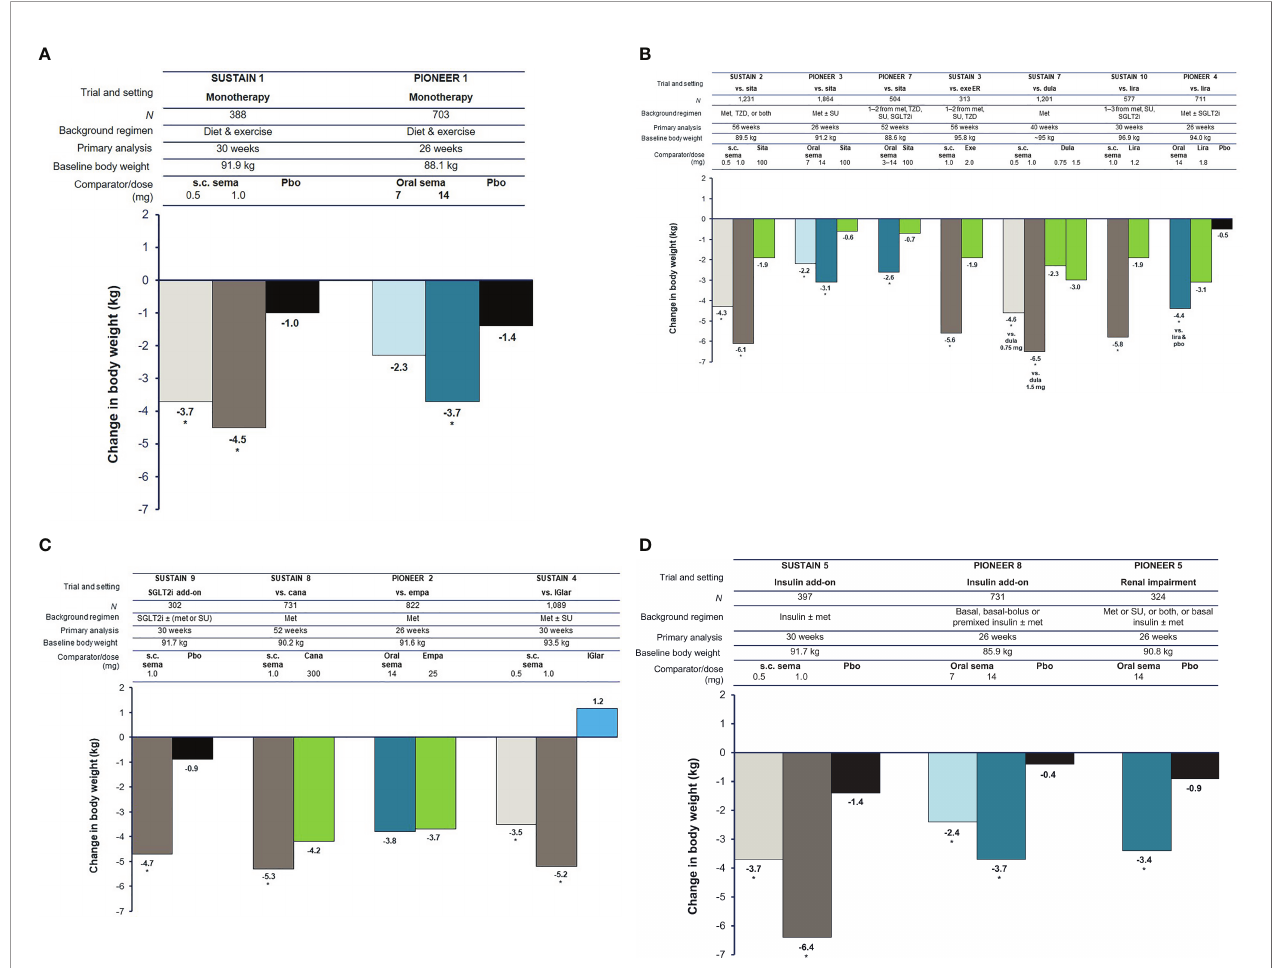
FIGURE 2 | Reductioninbodyweightwithsemaglutideandcomparators(16 – 20,22 – 26, 31,33). (A) TrialsinearlyT2D(3 – 4years). (B) TrialsinestablishedT2D(6 – 10 years) withincretin-basedtherapiesascomparators. (C) TrialsinestablishedT2D(6 – 10years)withother comparators. (D) TrialsinadvancedT2D(13 – 15years).For theSUSTAIN trials shown,estimatedmeanchangesfrom baselineinbodyweight includedonlydataobtainedbeforeinitiationofanyrescuemedicationorbeforeprematuretreatment discontinuation.For the PIONEERtrialsshown,estimatedmeanchanges frombaselineinbodyweightareregardless oftrialproductdiscontinuationor rescuemedication (treatmentpolicyestimand).Oralsemaglutide 3mgdailywasalso testedinPIONEER1,PIONEER3,andPIONEER 8; however, thisdoseisnotrecommendedas amaintenance dose[RybelsusSPC] anddataarenotshown(exceptfor inPIONEER 7aspartofa fl exibledosingapproachinwhichinvestigatorscouldincreaseor decreasethedoseoforal semaglutidebetween3,7 and14mgaccordingtoef fi cacyandtolerabilitycriteriaandclinicaljudgment). * p <0.05 fortheestimatedtreatmentdifferencewithsemaglutidevs. comparator. Cana, canagli fl ozin; dula, dulaglutide; empa, empagli fl ozin;ER,extendedrelease;exe,exenatide; IGlar,insulinglargine;lira,liraglutide;met,metformin;pbo, placebo; s.c.,subcutaneous; sema,semaglutide; SGLT2i, sodium-glucoseco-transporter-2inhibitor; sita,sitagliptin;SU, sulfonylurea; T2D, type2 diabetes;